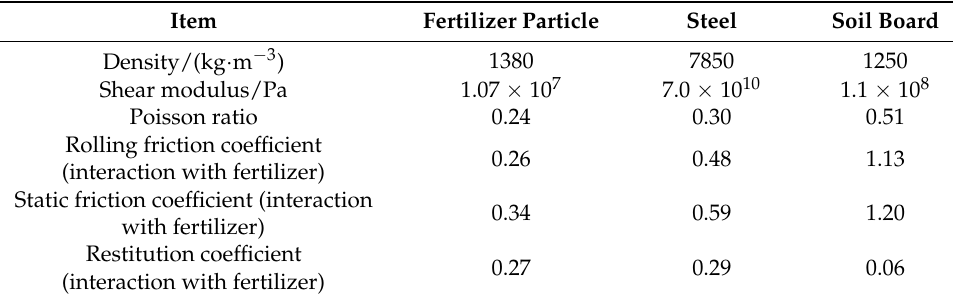
Table 2. Material property parameters of the simulation